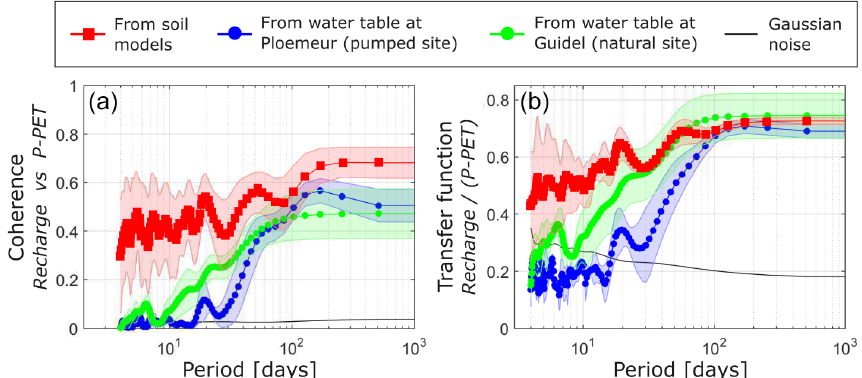
Figure 9. Coherence (a) and transfer function (b) between P − PET and recharge fluctuations estimated from the observed water table at Ploemeur (in blue) and Guidel (in green) sites or between P − PET and potential recharge fluctuations obtained from soil models. The coherence and transfer function of a 25mm per month Gaussian noise is given as a reference (in black). Shaded areas illustrate the three soil model’s range (Thornthwaite, GR4J, SURFEX) (in red) and the variability of estimated recharge fluctuations from several wells (in blue and green). P and PET refer to precipitation and potential evapotranspiration